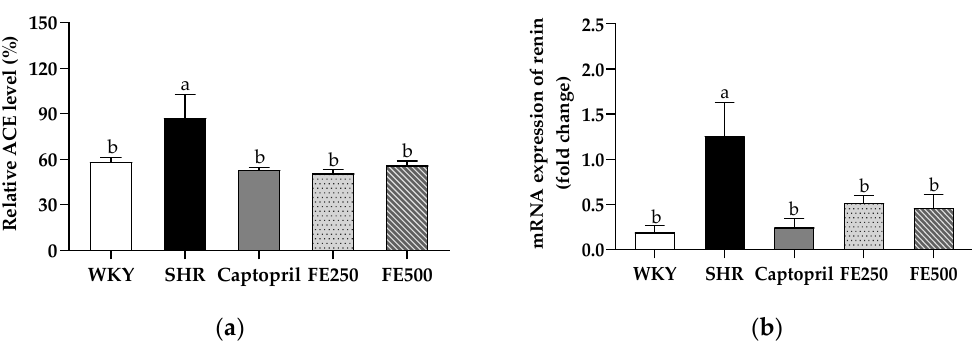
Figure 3. ACE level in the serum ( a ) and mRNA expression of renin in the kidney ( b ) of the SHRs after 8 weeks of oral administration. ACE, angiotensin-converting enzyme; WKY, Wistar Kyoto rats; SHR, Spontaneously hypertensive rats; Captopril, SHRs treated with 50 mg/kg bw of captopril; FE250, SHRs treated with 250 mg/kg bw of FE; FE500, SHRs treated with 500 mg/kg bw of FE; FE, finger millet ethanol extract. Data are expressed as means ± standard errors of the mean ( n = 6). Different letters above the bars indicate significant differences at p < 0.05.